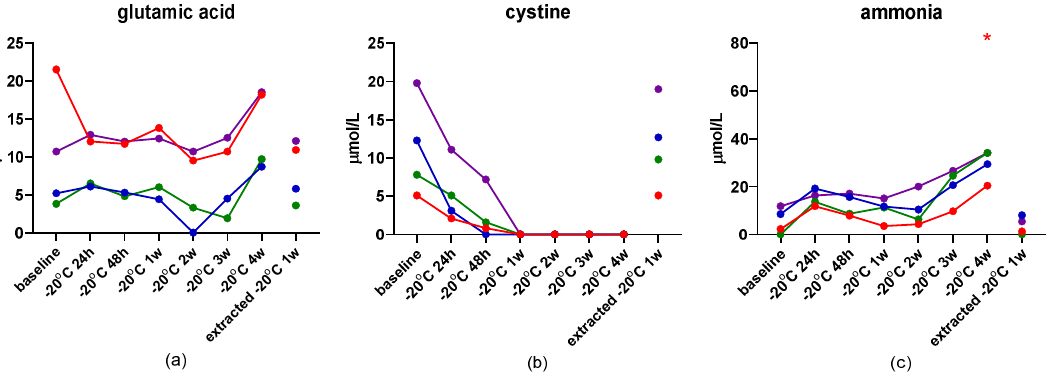
Figure 3. Stability of serum concentrations of glutamic acid ( a ), cystine ( b ), and ammonia ( c ) in naïve serum stored at −20 °C for up to 4 weeks and deproteinized serum stored for 1 week. Red asterisks indicate significance ( p < 0.05) compared to baseline.